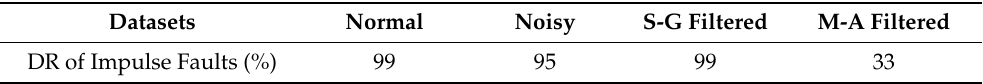
Table 6. Influence of random noise on fault detection.